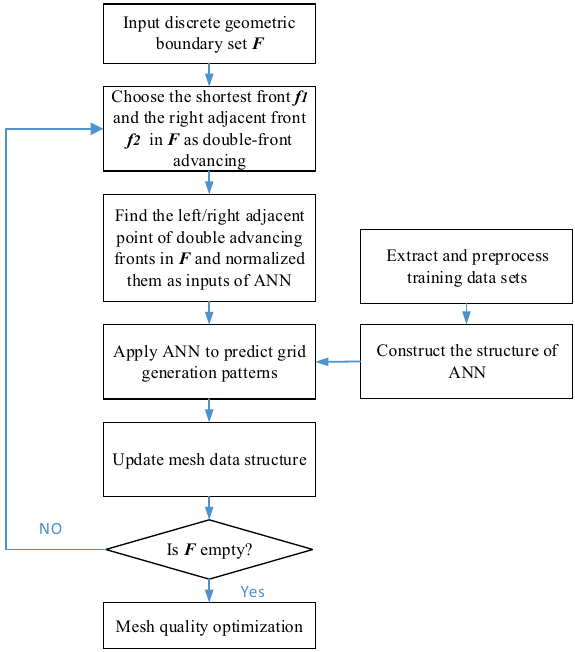
Figure 7. Flowchart for generation isotropic triangular mesh by